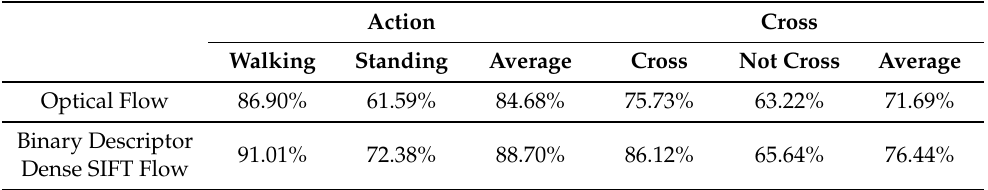
Table 6. Test accuracy of the position-information feature-image added two-stream CNN with the detector and tracker between the optical flow and binary descriptor dense SIFT flow.